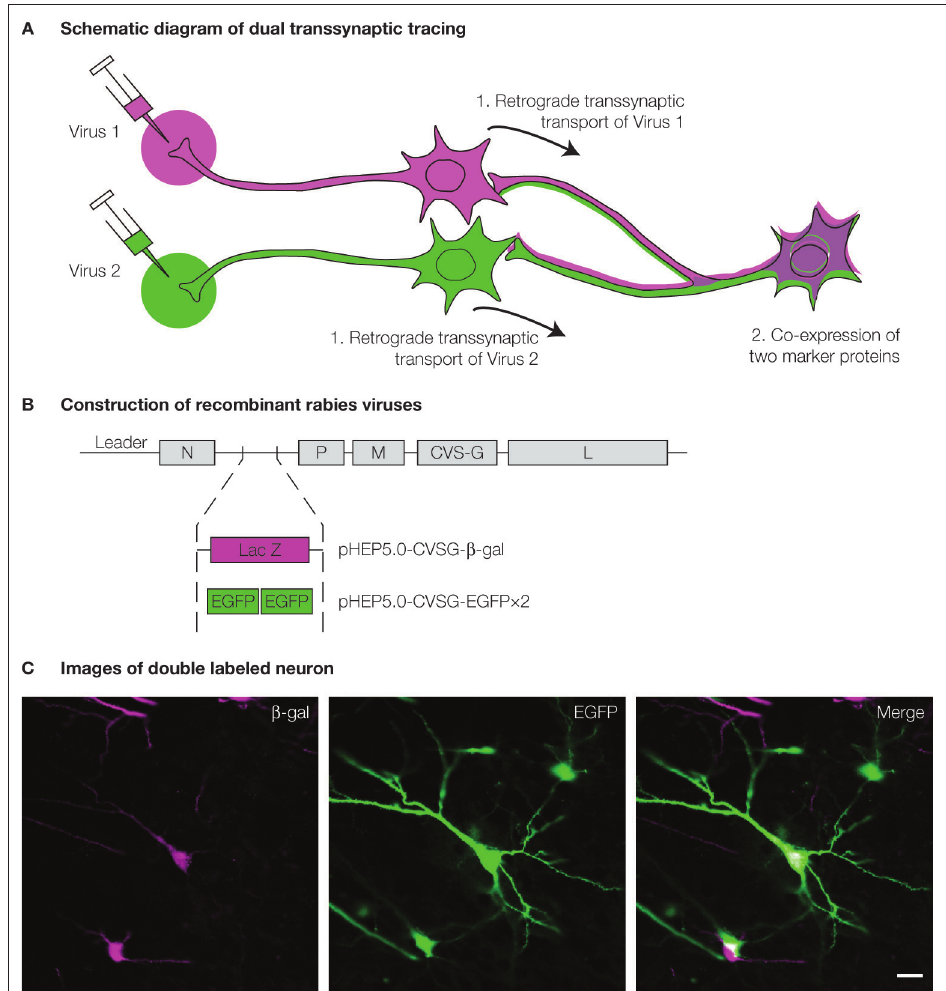
Figure 2 | Dual viral tracing using genetically modified virus. (A) Neurons which have a divergent projection to two brain regions will be infected by retrograde transsynaptic transport of the two recombinant viruses, and will be double-labeled by the co-expression of the two marker proteins. (B) Two RV recombinants were generated for dual viral tracing by inserting different marker genes encoding either β -gal or EGFP. (C) Neuron double-labeled by β -gal (magenta, left panel) and EGFP (green, center panel) can be seen in white in the merged image (right panel). Scale bar = 20